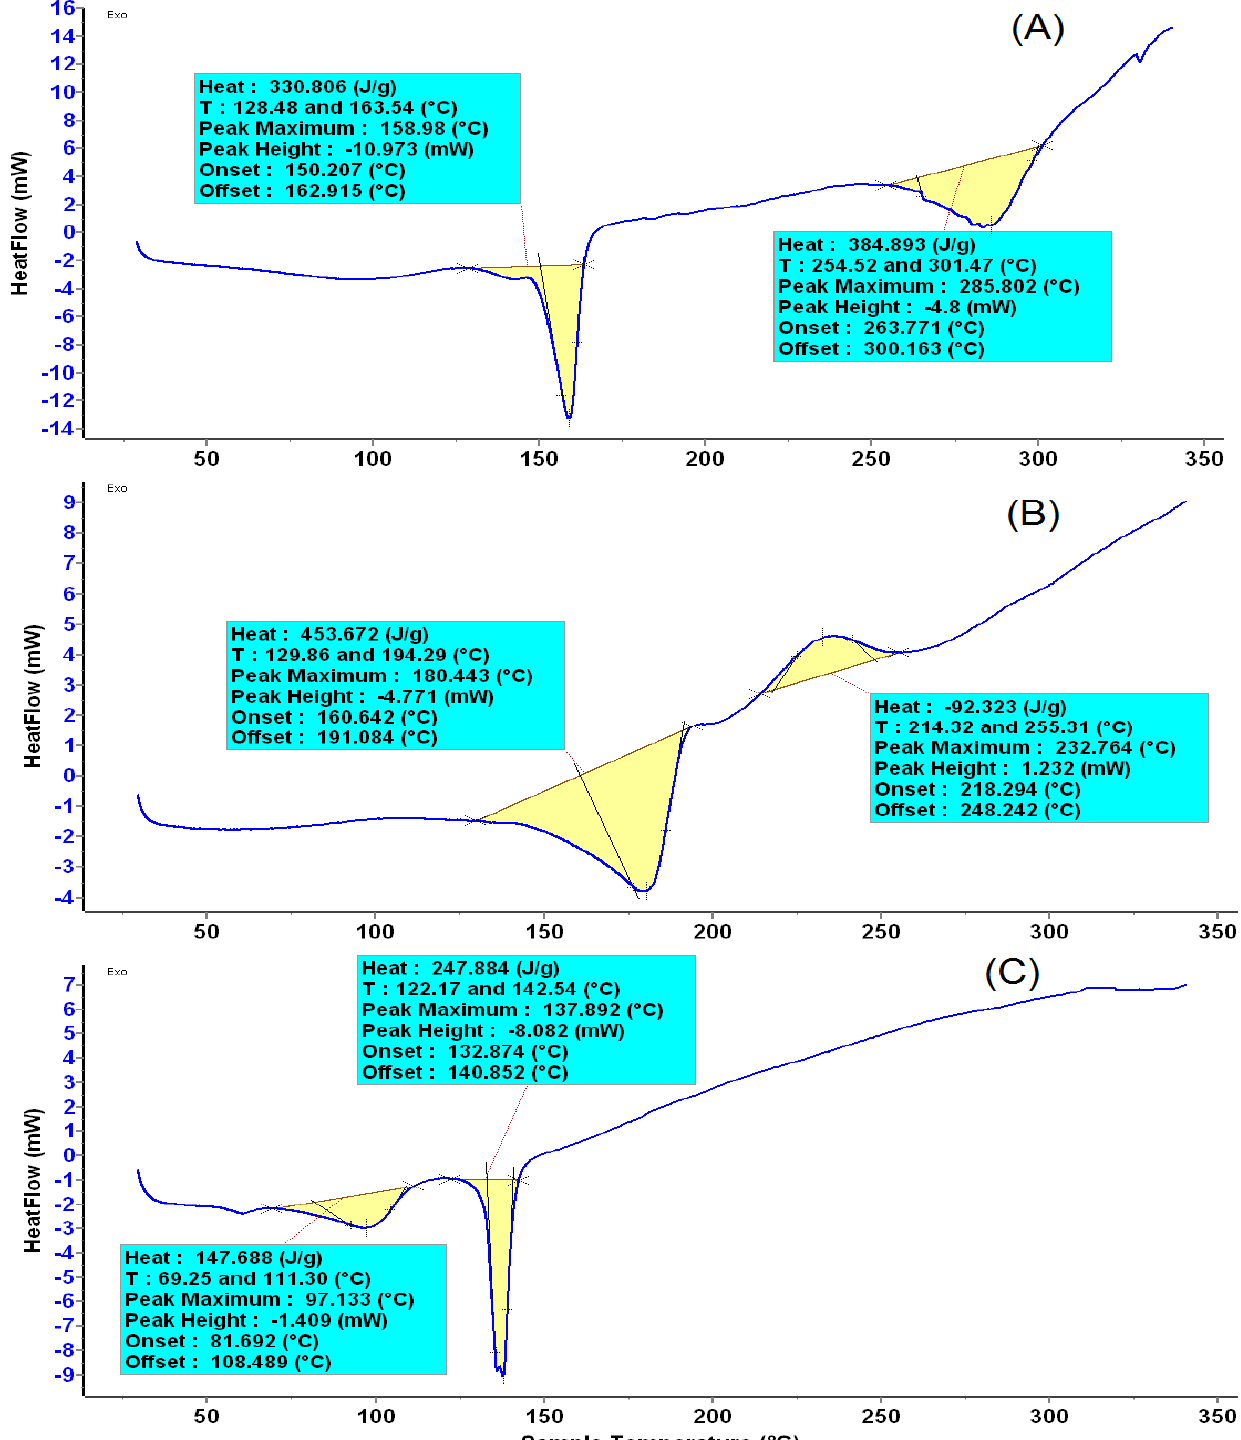
Figure 4. The melting-point thermogram of β -SIT-Alg/Ch-NPs-FA ( A ); Folic acid ( B ); and β -SIT ( C ).